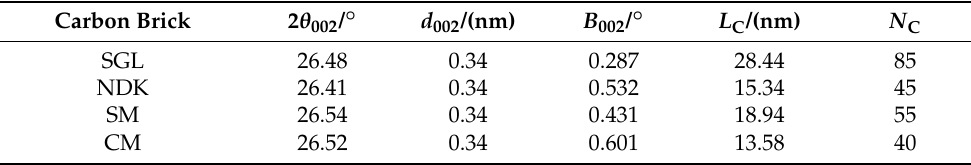
Table 4. Structural parameters of carbon bricks measured from the XRD spectra. Carbon